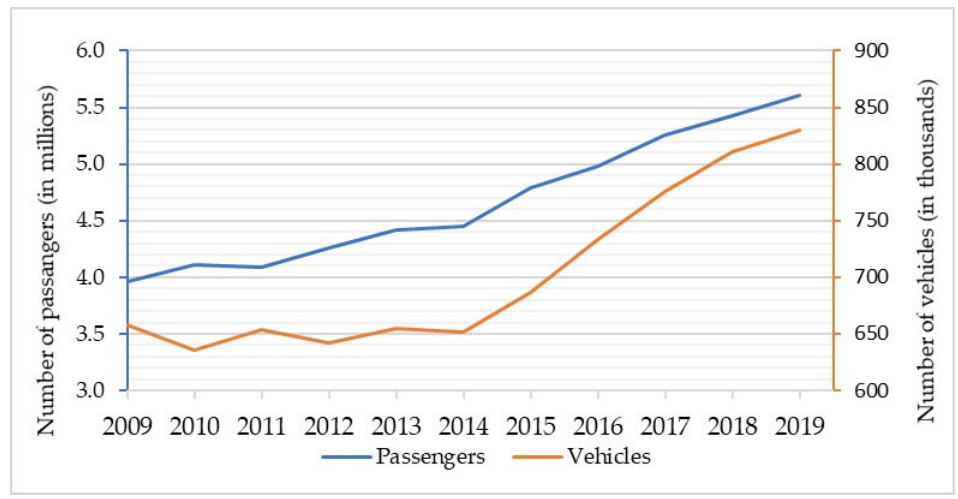
Figure 2. Number of passengers and vehicles transported in the port of Split from 2009 to 2019.